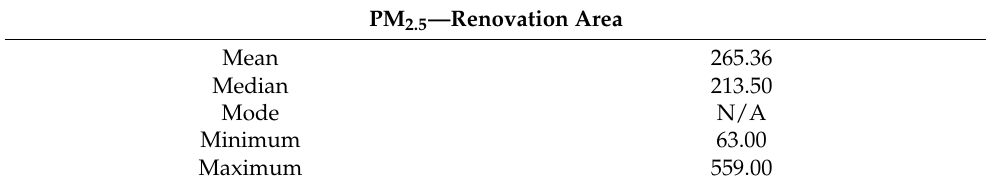
Figure 5. The levels of PM 2.5 concentration and the number of workers in the renovation area throughout a 14-day monitoring campaign in a large shopping mall. Table 2. Descriptive statistics for PM 2.5 in the renovation area (in µ g/m 3 ).